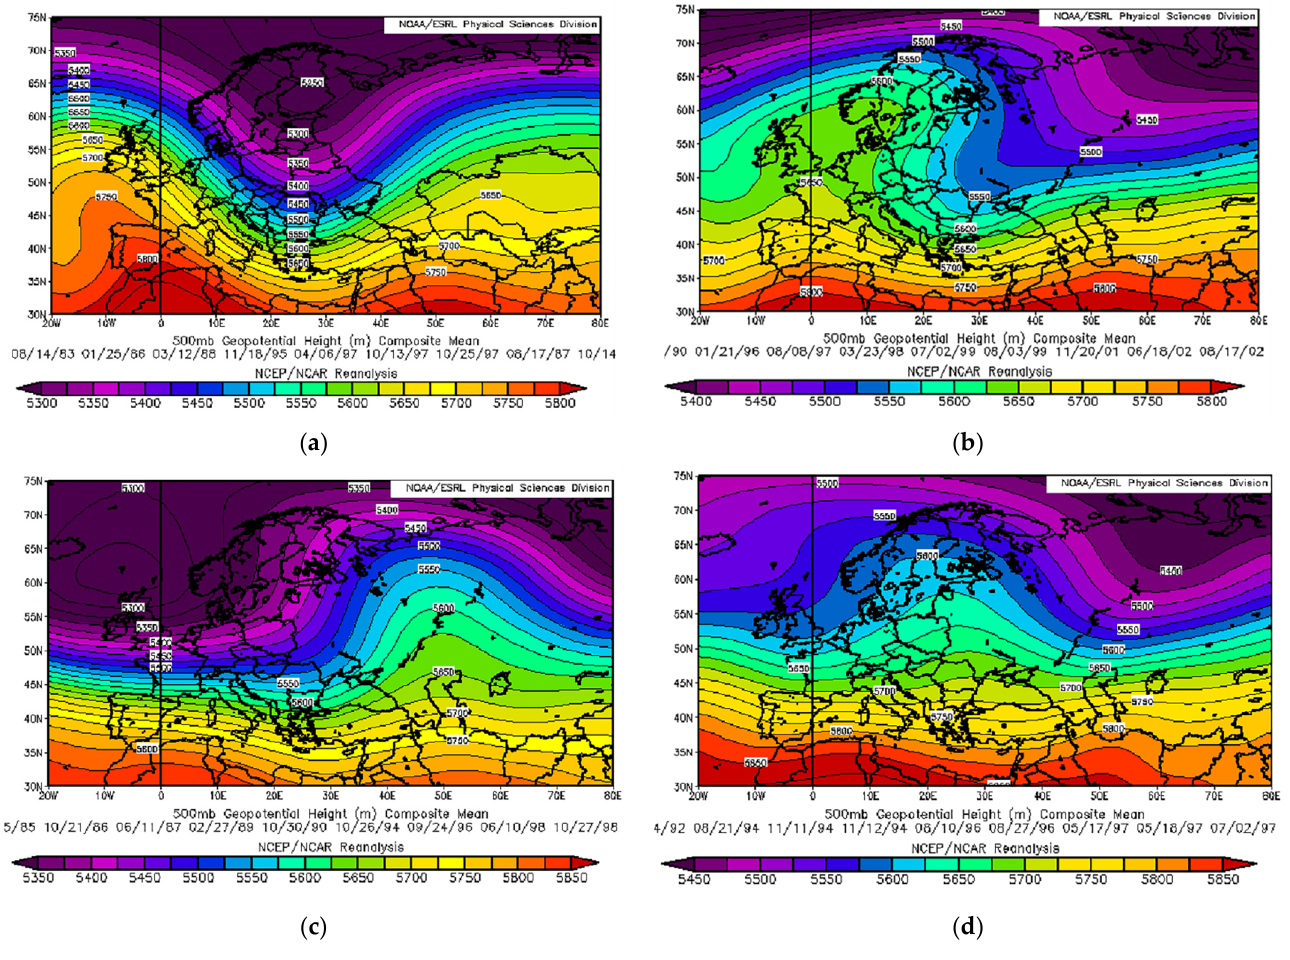
Figure 7. Composites of baric fields in the middle troposphere (500 hPa) during SWPp in the Crimean region: ( a ) mixed, ( b ) western, ( c ) eastern, and ( d ) central. Plots were built at Physical Sciences Laboratory (NOAA) site http://www.esrl.noaa.gov/psd/.